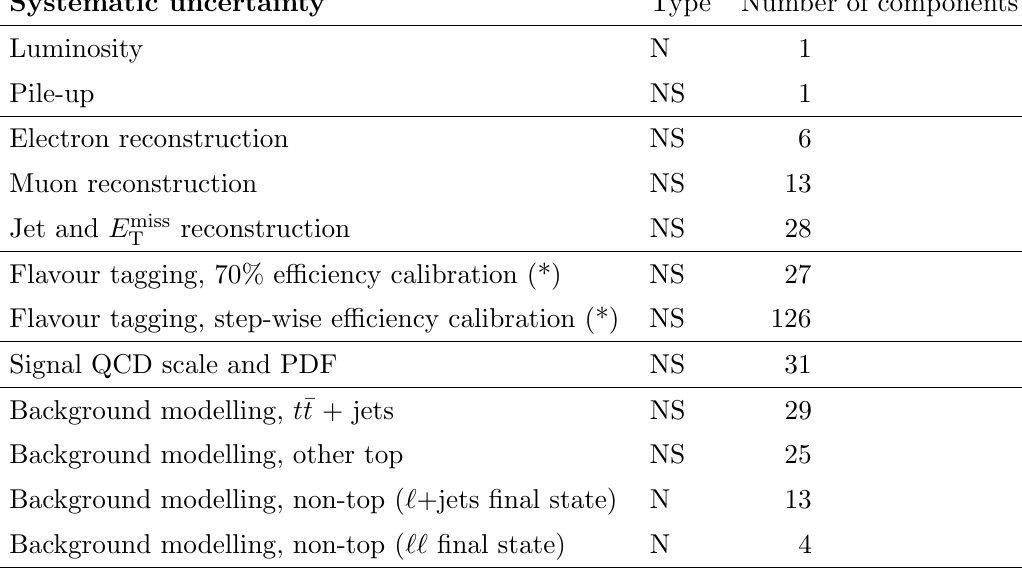
Table 2. List of systematic uncertainties considered. The details of the systematic uncertainties are described in section 6. ‘N’ indicates that the uncertainty is taken as normalisation-only for all processes and channels a(cid:11)ected, while ‘NS’ means that the uncertainty applies to both normalisation and shape. The systematic uncertainties are split into several components for a more accurate treatment. Flavour-tagging uncertainties marked (*) are di(cid:11)erent for the two sets of calibrations: the step-wise e(cid:14)ciency calibration for m (cid:20) 300 GeV, and the 70% e(cid:14)ciency point calibration H +